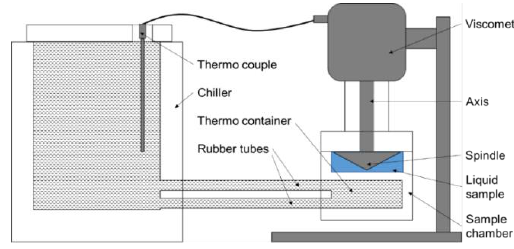
Figure 1. A schematic of the viscosity measurement set-up.